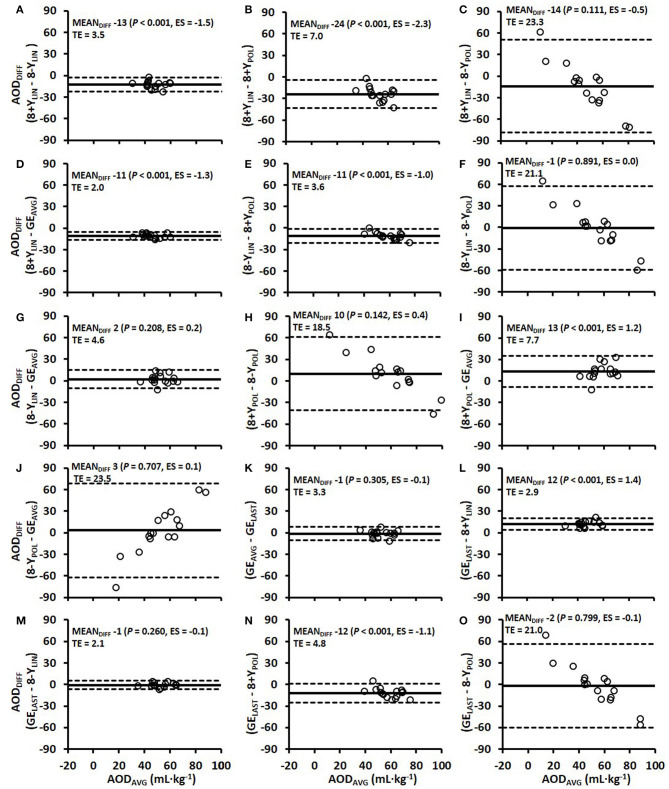
Bland-Altman plots for the six various models of estimating the accumulated oxygen deficit (AOD) associated with the 4-min time trial using the diagonal stride sub-technique (A–O). Bland-Altman plots represent the mean difference (MEANDIFF) in the AOD ± 95% (1.96 SD) limits of agreement between the methods. Abbreviations: AODDIFF, the difference in AOD; TE, typical error; ES, Hedges's gav effect size, 8+YLIN and 8-YLIN, the 8 × 4-min linear maximal accumulated O2 deficit methods with the baseline V.O2 as a Y-intercept either included (8+Y) or excluded (8-Y); 8+YPOL and 8-YPOL, the 8 × 4-min polynomial (second degree) maximal accumulated O2 deficit methods with the baseline V.O2 as a Y-intercept either included (8+Y) or excluded (8-Y); GEAVG, the gross efficiency method based on the average of eight submaximal stages; GELAST, the gross efficiency method based on the last submaximal stage.